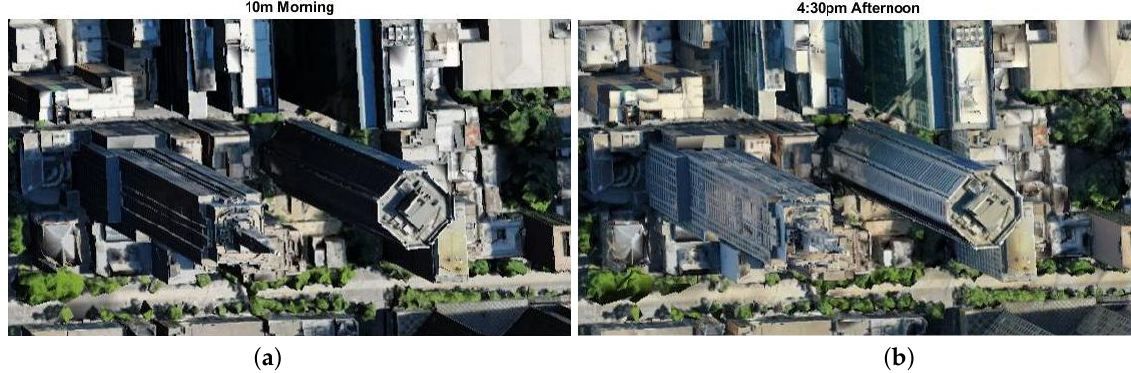
Figure 11. Illustration of image difference due to different sun illumination directions. ( a ) Aerial image taken at 10 a.m. in the morning. ( b ) Georeferenced image taken at 4:30 p.m. in the afternoon.